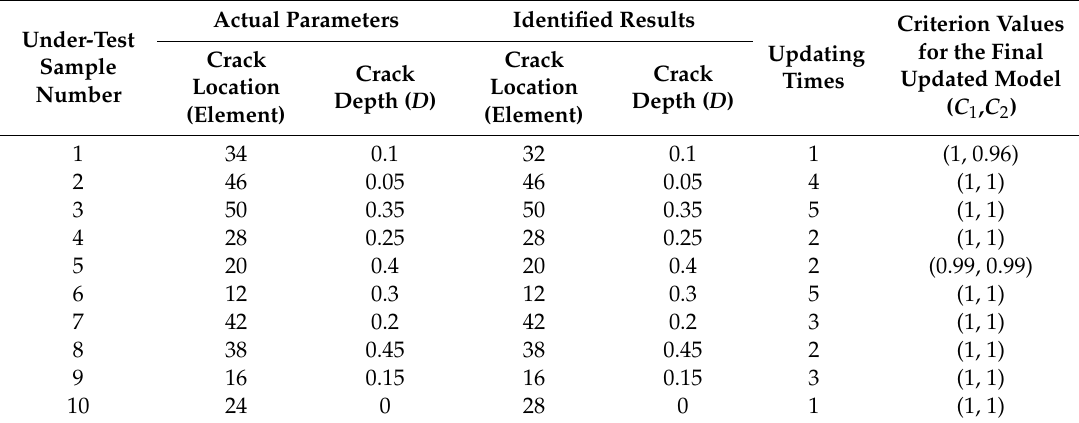
Figure 9. Update process of the under-test samples. ( a ) Identification process for all samples; ( b ) identification process and corresponding value of identified feature for sample 6. Table 3. Crack identification results of the under-test samples.